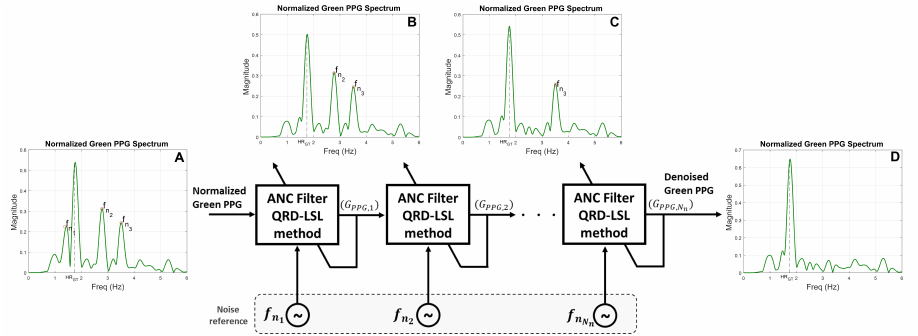
Figure 9. Cascading Adaptive Noise Canceler (C-ANC) block diagram. Spectrum A is of the noise- contaminated green PPG signal which is fed to the C-ANC. Spectrum B represents the green PPG signal’s frequency spectrum after removal of the first noise frequency component, f n is obtained after removing a second noise frequency component, f n removed from the input signal. Spectrum D is of the clean green PPG signal. It is obtained at the output of the C-ANC after all noise frequency components were